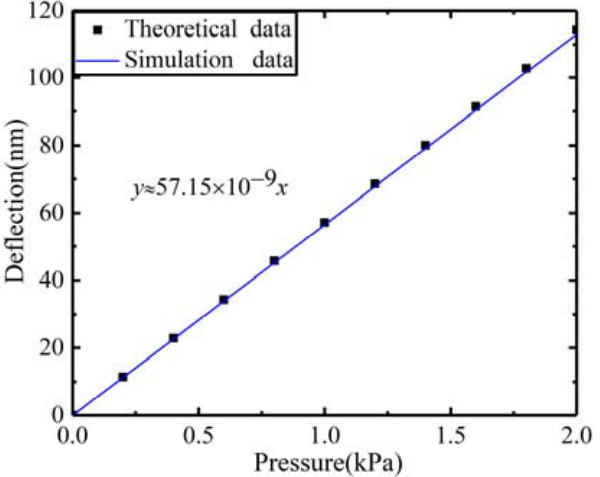
Figure 3. The maximum deflection when loaded pressure.